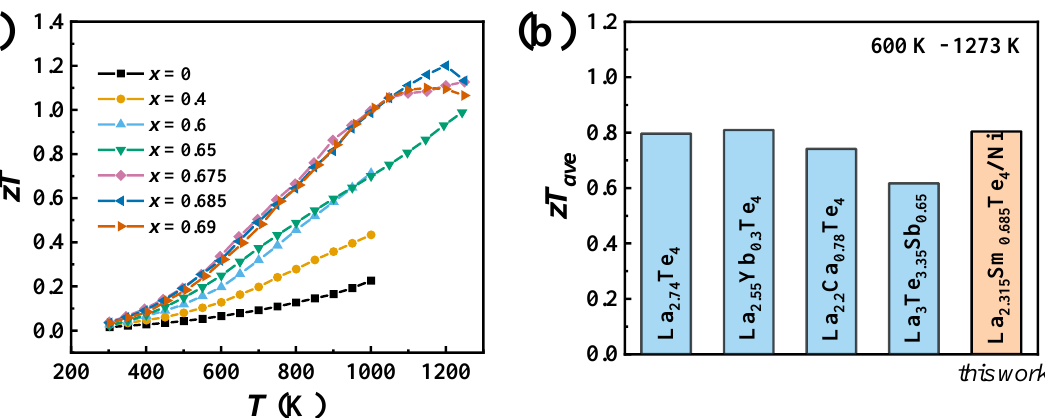
Figure 4. ( a ) Temperature dependence of zT for the as-synthesized La 3 − x Sm x Te 4 /10 vol.% Ni composites ( x = 0, 0.4, 0.6, 0.65, 0.675, 0.685, 0.69). ( b ) Comparison of the average zT ave with optimized hall carrier concentration for La 2.315 Sm 0.685 Te 4 /Ni composite and for the reported La 3 − x Te 4 matrix [15], Yb [23], Ca [22], Sb-doped [24], and La 3 Te 4 -based compounds.